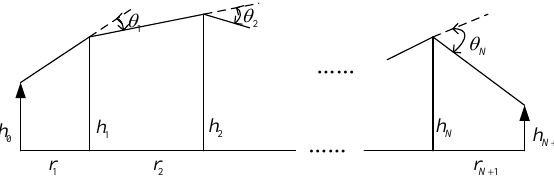
Figure 4. Geometry for multiple knife-edge diffraction.